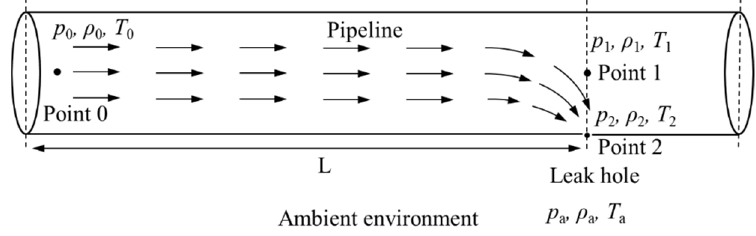
Figure 1. Schematic diagram of the gas leakage process in the hole model.